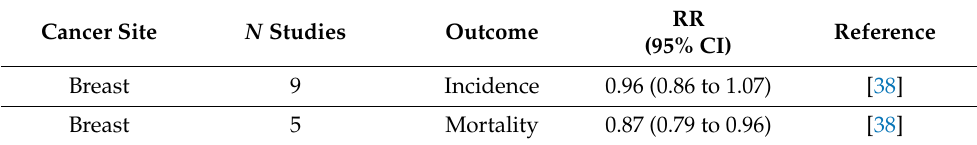
Table 3. Meta-analyses of breast cancer risk from vitamin D RCTs.